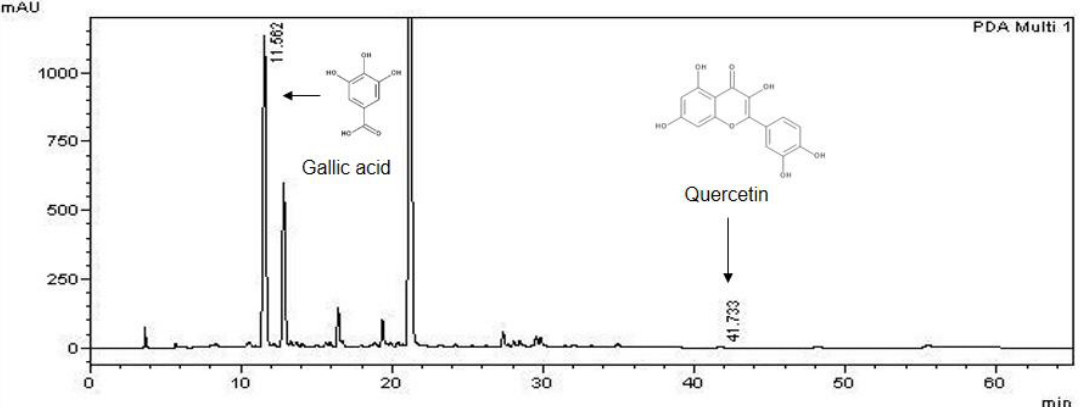
Figure 1. HPLC chromatogram. Gallic acid and quercetin in CM methanol extract were quantified using HPLC analysis. The peaks at the retention time of 11.56 and 41.73 min represented as gallic acid and quercetin, respectively.